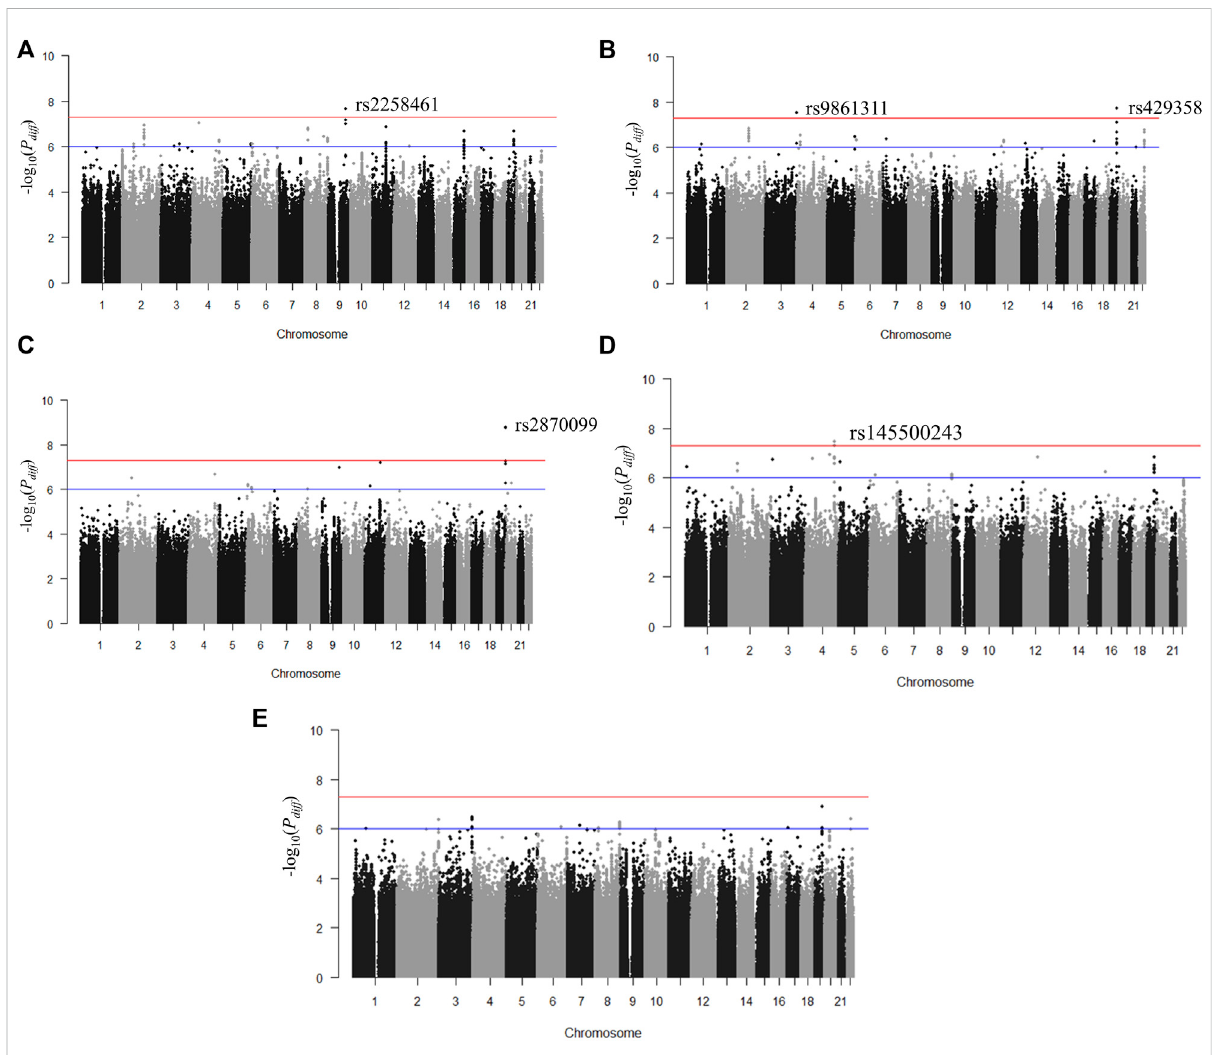
FIGURE 2 Manhattan plots for p -value of T-scores in strati fi ed analyses between groups Q1 and Q4. (A) Body mass index, (B) body fat percentage, (C) waist-hip ratio, (D) waist circumference, and (E) hip circumference. The red horizontal line ( p < 5 × 10 – 8 ) denotes the threshold for genome-wide signi fi cance.